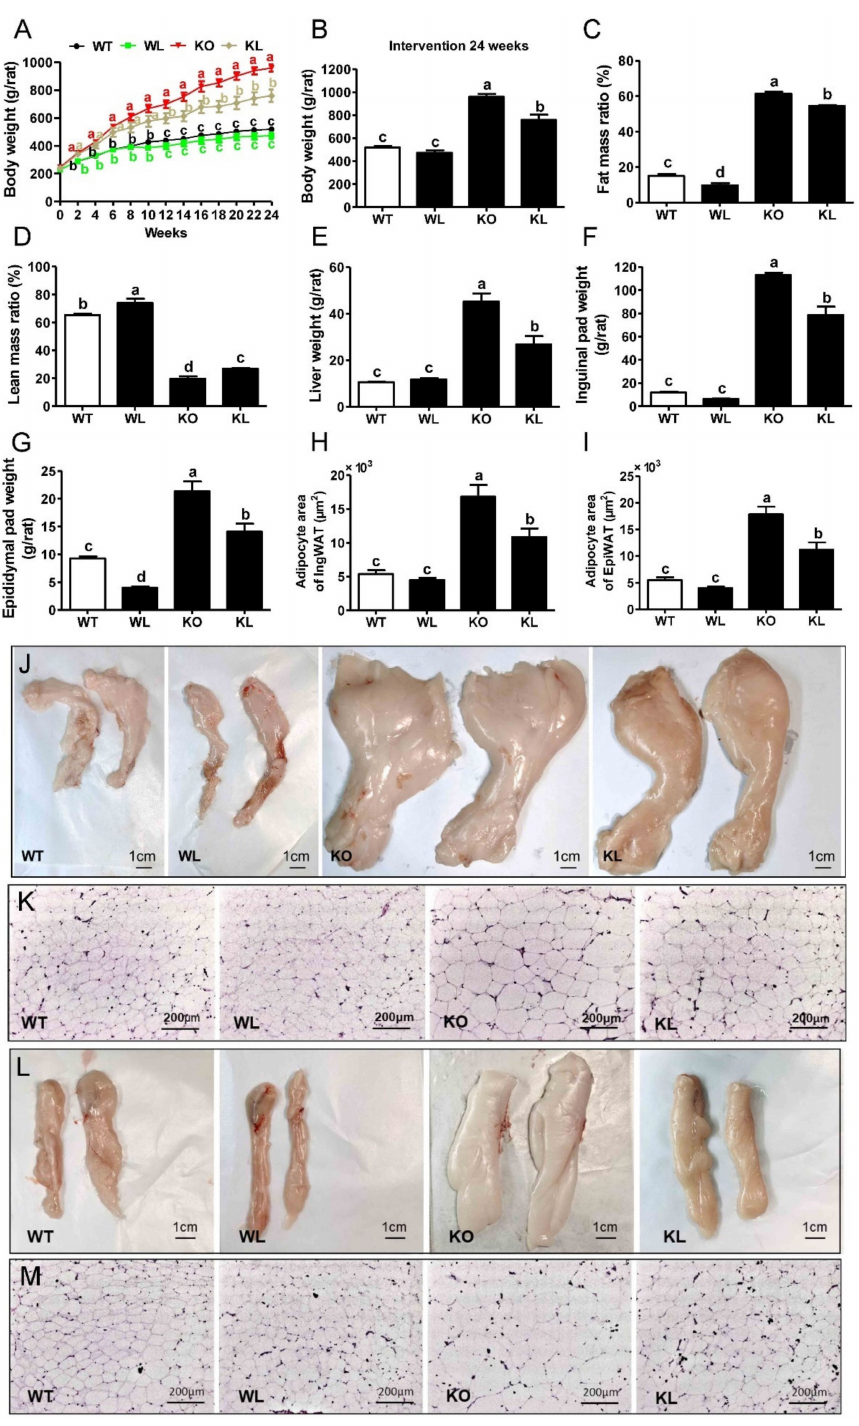
Figure 1. LWE ameliorated phenotype of obesity in Lepr − / − rats. LWE, water extract of large yellow tea; WT, wild type rat; WL, wild type rat with LWE intervention; KO, leptin receptor knockout rat; KL, leptin receptor knockout rat with LWE intervention. ( A ) Body weight curves, ( B ) body weight, ( C ) fat mass ratio, ( D ) lean mass ratio, ( E ) liver weight, ( F ) inguinal pad weight, and ( G ) epididymal pad weight of the rats were measured, respectively. The adipocyte area of ( H ) inguinal pad and ( I ) epi- didymal pad; the image of ( J ) inguinal pad and ( L ) epididymal pad in different groups of rats; the image of the inguinal pad ( K ) and epididymal pad ( M ) by H&E staining were at 100 × magnification. Values are means ± SEM (n = 4–6). Columns with different letters are significantly different ( p <